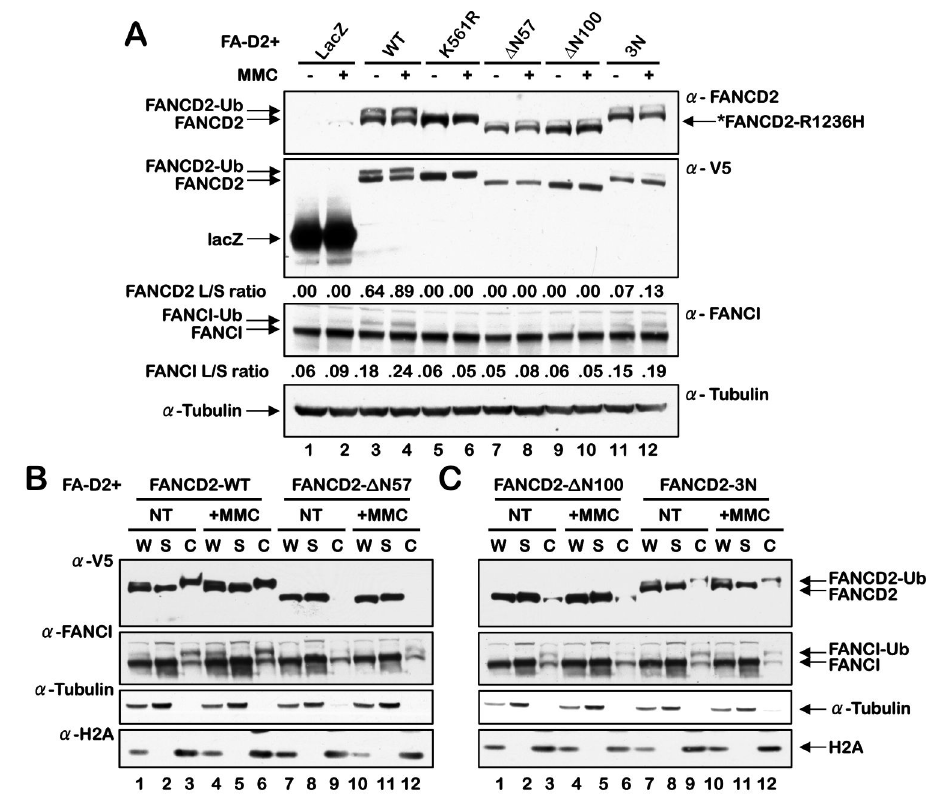
Figure 4. The FANCD2 NLS is required for efficient FANCD2 and FANCI monoubiquitination and chromatin association. ( A ) FA-D2 cells stably expressing LacZ, FANCD2-WT, FANCD2-K561R, FANCD2-∆N57, FANCD2-∆N100 and FANCD2-3N were incubated in the absence and presence of 250 nM MMC for 18 h, and whole-cell lysates were immunoblotted with antibodies to FANCD2, V5, FANCI and α-tubulin. The FANCD2 and FANCI L/S ratios are the ratios of monoubiquitinated to nonubiquitinated protein, and were calculated by measuring protein band intensities using ImageJ image processing and analysis software (http://rsb.info.nih.gov/ij/). ( B and C ) FA-D2 cells stably expressing FANCD2-WT, FANCD2-∆N57, FANCD2-∆N100 and FANCD2-3N were treated as above and cell pellets were fractionated into soluble (S) and chromatin-associated (C) fractions. Fractions were immunoblotted with antibodies against V5, FANCI, α-tubulin and H2A. W, unfractionated whole cell extract.